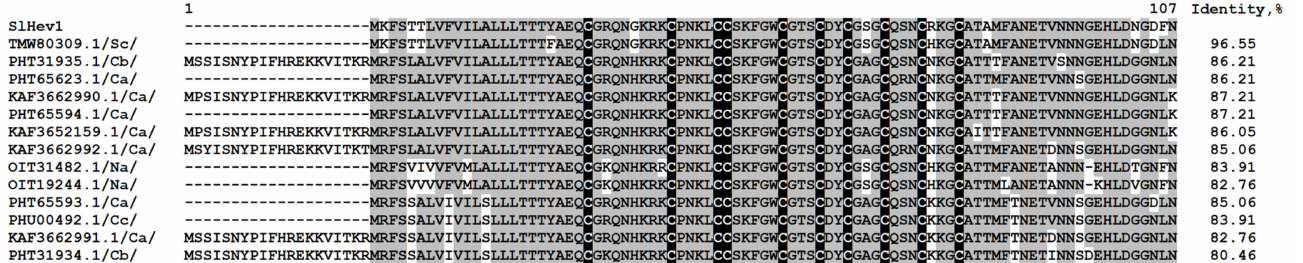
Figure 7. Multiple sequence alignment of hevein-like peptide precursors of S. lycopersicum SlHev1 and T. kiharae WAMP-1 (P85966.2), hevein of Hevea brasiliensis (1Q9B_A) and hevein-like peptides from Pharbitis nil Pn-AMP1 (P81591), E. ulmoides EAFP1 (P83596), E. europaeus Ee-CBP (Q7Y238), Fagopyrum esculentum Fa-AMP1 (P0DKH7), Amaranthus caudatus Ac-AMP2 (Q9S8Z7), A. retroflexus Ar-AMP (Q5I2B2), and Beta vulgaris IWF4 [34]. Cysteine residues are shaded black, and identical amino acids are shaded gray. The arrangement of disulfide bonds is shown above the alignment.